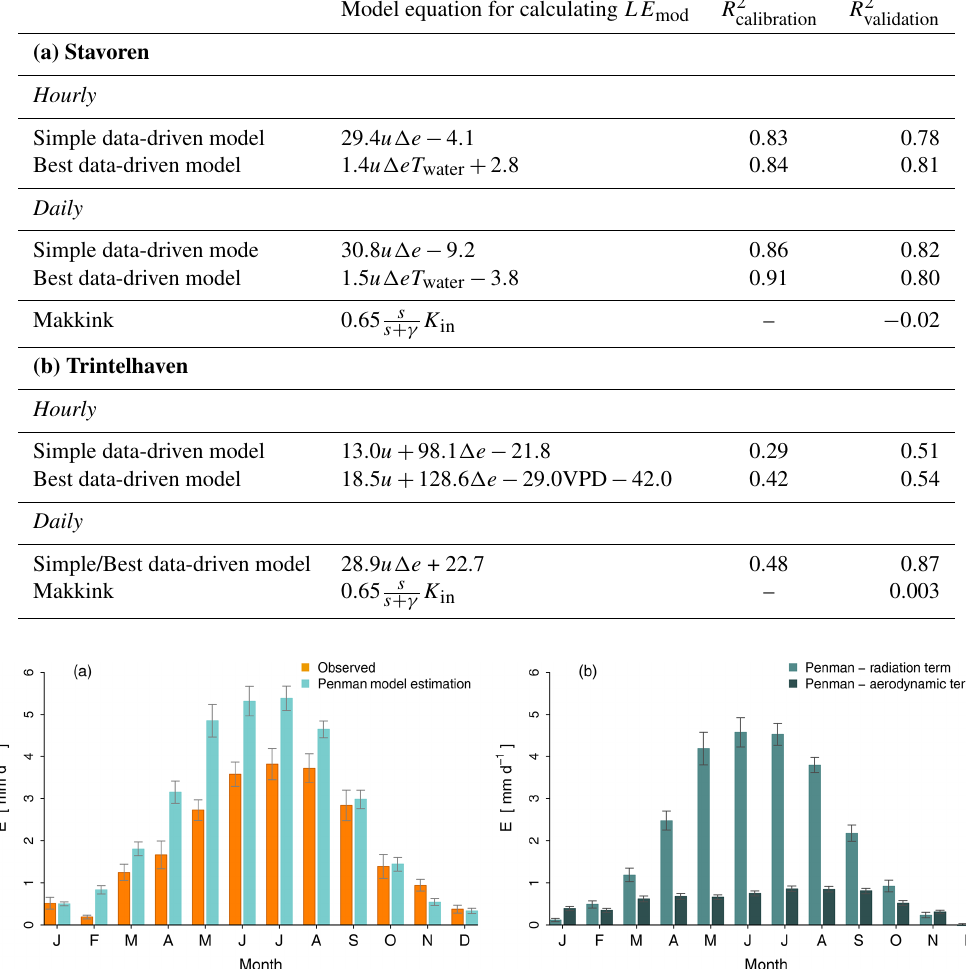
Figure 9. Comparison of the annual cycle of observed open water evaporation in Stavoren (orange) and estimated evaporation (blue) using Penman’s model (a) based on daily data in 2019. The individual terms of Penman’s model are displayed in panel (b) , which shows the similarity of the annual cycle between observed open water evaporation and the radiation term of Penman’s model. The bars indicate the monthly average evaporation, and the whiskers represent the uncertainty, which is defined as the standard deviation divided by the square root of the number of